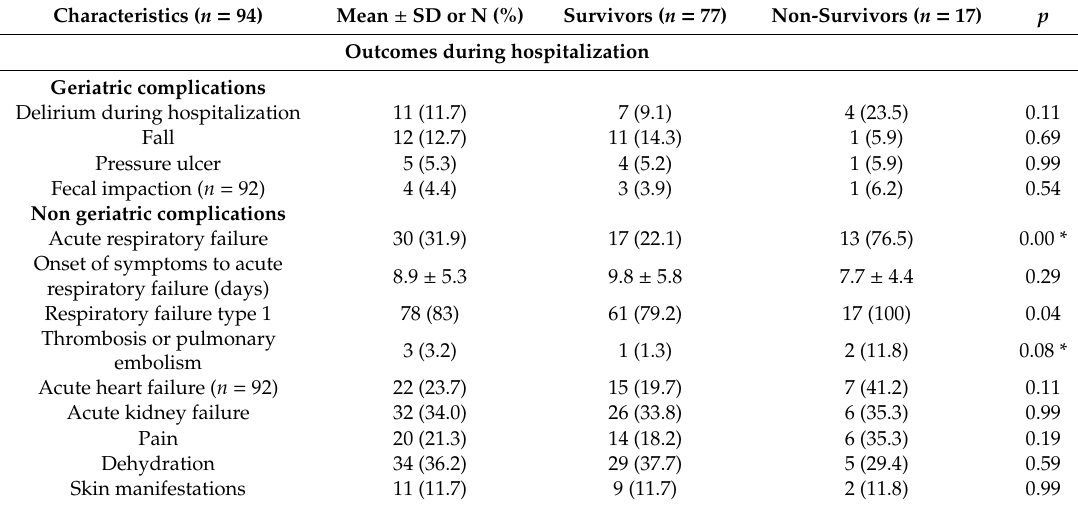
Table 4. Follow-up and outcomes of older patients with COVID-19